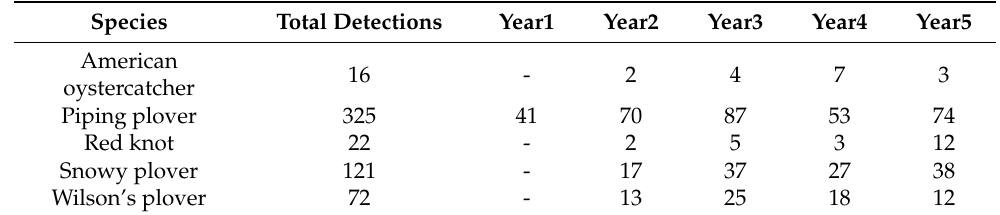
Table 2. Summary of shorebird observations showing the total number of occupied grid cells when transformed into a binary (0/1)